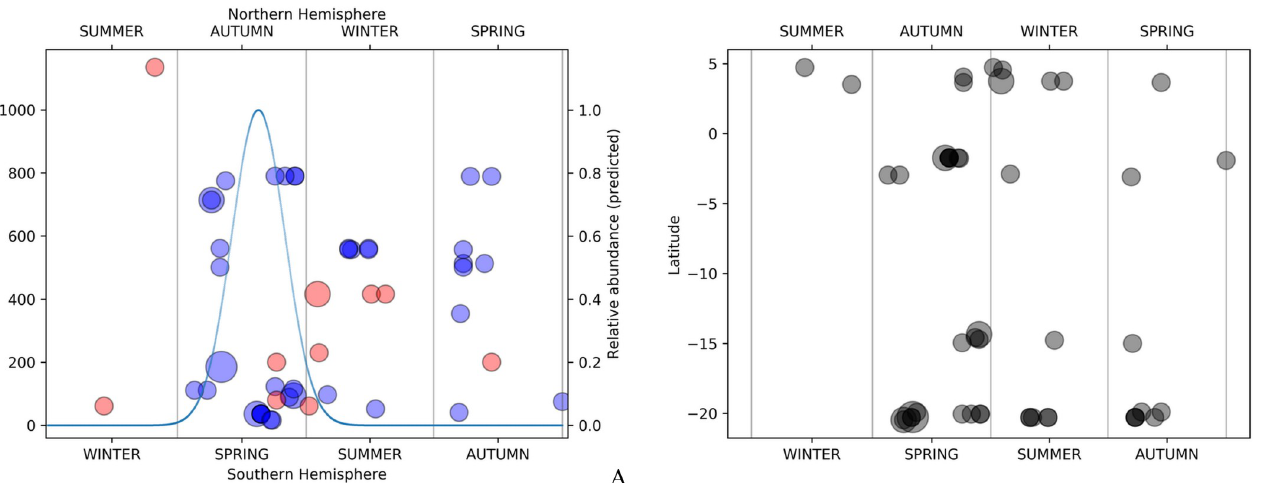
Fig 23. Summary of collecting records for the females of C . metamorphus sp. nov. Circles are collecting events; smallest circles = 1 specimen each, largest circle = 3 specimens. Range records plotted as two values, i.e., starting and ending dates. (A) Records grouped by altitude; red circles show specimens from the northern hemisphere. Relative abundance of specimens from the southern hemisphere shown as a best fit Gaussian curve. (B) Records grouped by latitude.